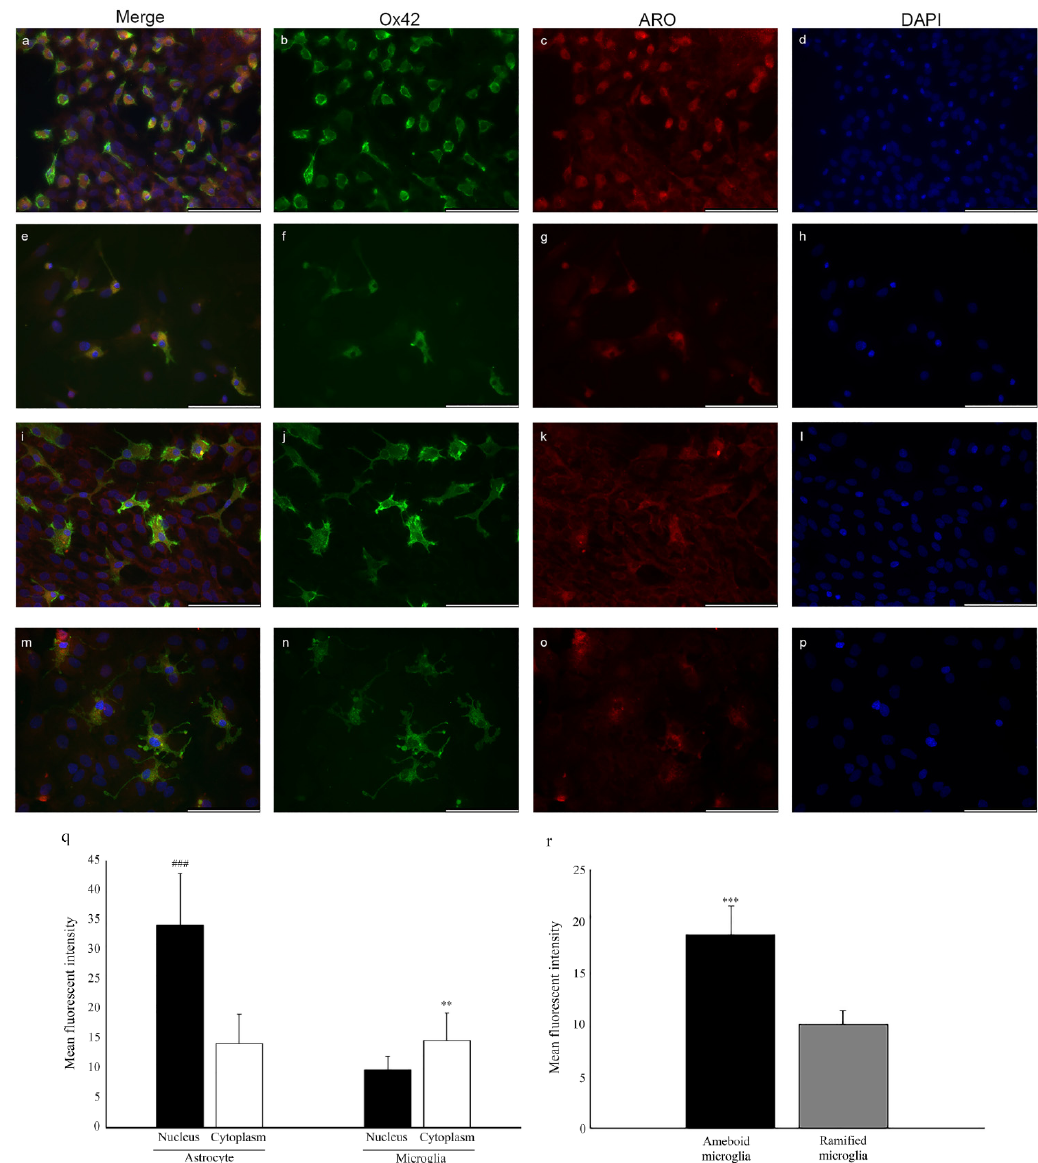
Figure 6. Localization of aromatase in microglia cells. CD11b/c (Ox42)-labelled microglia cells (green) isolated from newborn rats show Aro (red) expression, but the signal is detectable exclusively in the cytoplasm. Microglia cells with typical ameboid/activated morphology ( a – h ) show stronger Aro expression compared with the resting/ramified forms ( i – p ), where Aro immunopositivity is much weaker. Aro signal is weak or undetectable in the branches of ramified microglia cells. Quantitative analysis of the fluorescent intensity confirmed that the Aro signal is significantly higher in the cytoplasm of ameboid cells (18.64 ± 2.81; n = 15) than in ramified cells (9.98 ± 1.35; n = 15) ( r ). Although Aro is not presented in the nucleus of microglia cells, a low level of fluorescent intensity was detectable in the nuclear area due to the overprojection of staining of neighbouring cells from the upper and lower cellular layers and/or the overlapping of cytoplasmic signal, but its level was significantly lower (9.71 ± 2.31; n = 45) than the cytoplasmic Aro intensity (14.67 ± 4.68; n = 45). The analysis of mean fluorescent intensity also revealed that the level of Aro immunopositivity in the cytoplasm is similar in astrocytes (14.20 ± 4.9; n = 54) and microglia cells ( q ). Data are presented in mean ± SD. ** p < 0.01, *** p < 0.001, ### p < 0.001. Asterisks indicate the significance between microglia cells. Pound (###) indicates the significance between astrocytes and microglia. Scale bar: 100 μ m.